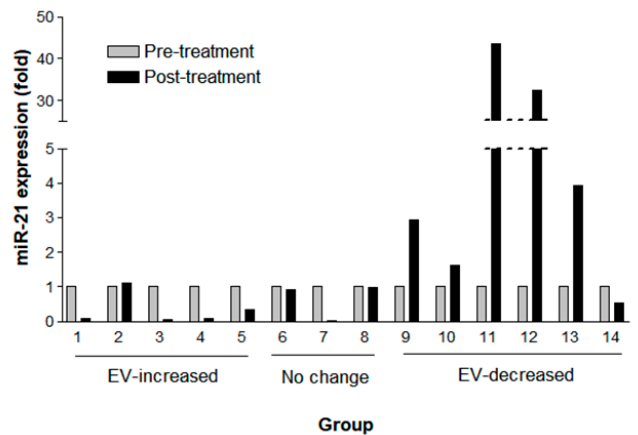
Figure 5. Fold change of miR-21 expression by digital droplet PCR paired pre-treatment (gray column) and post-treatment (black column) CSF samples according to EV changes of increased (n = 5), ‘no change’ (n = 3), and decreased (n = 6) EV concentration after the intraventricular chemotherapy. CSF extracellular miR-21 was detected by digital droplet PCR and normalized with EV concentration.